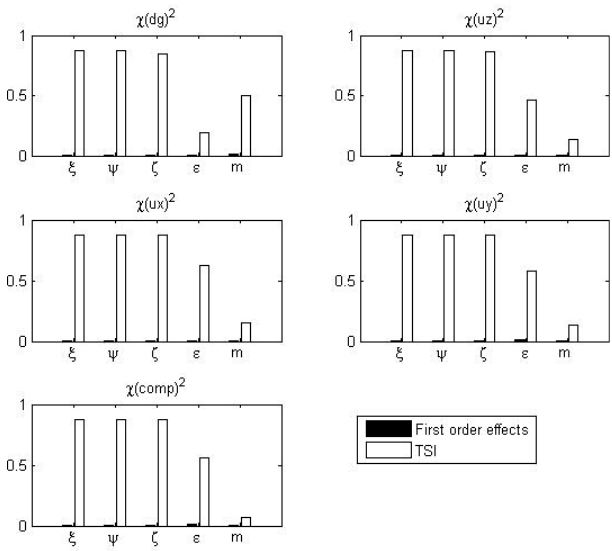
Fig. 5. First order effects and TSIs computed by E-FAST sensi- tivity analysis for the Monte Carlo sampling (one run consisting of 28645